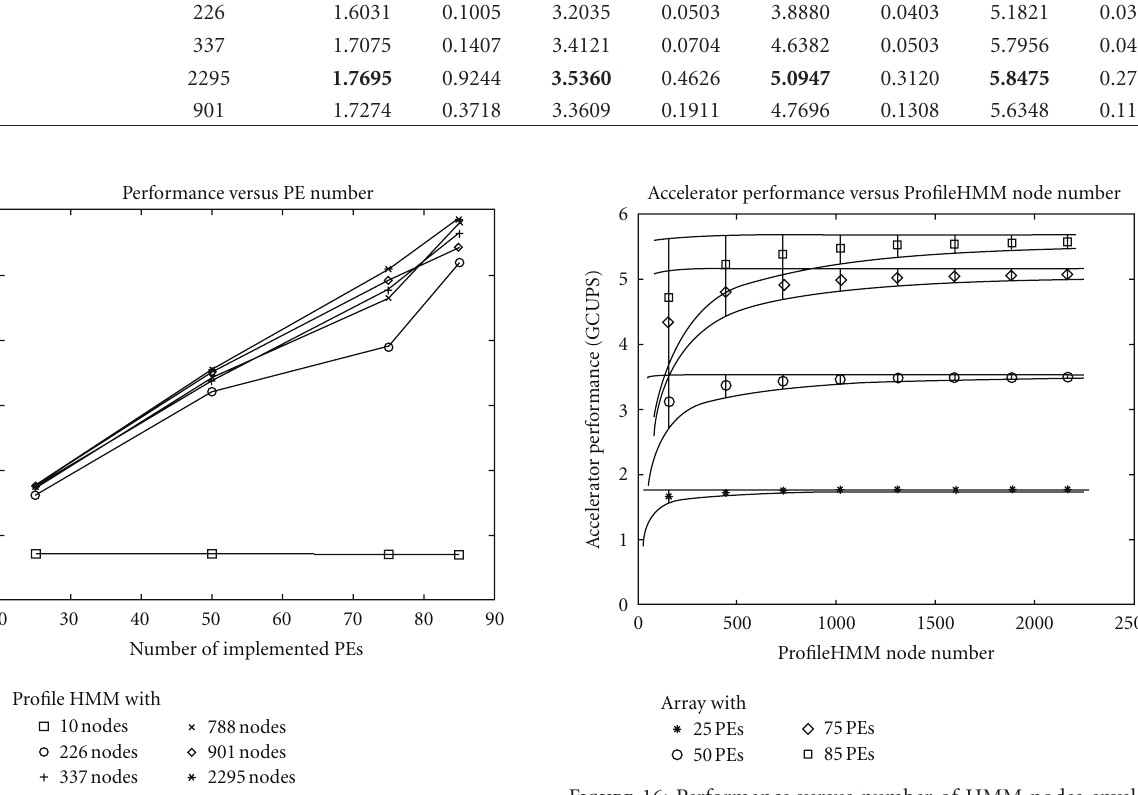
Figure 15: Performance versus number of PEs relation.